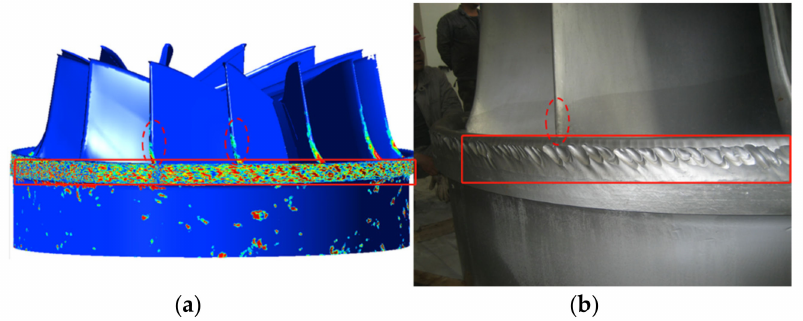
Figure 6. Sediment erosion at the clearance of the band. ( a ) CFD result; ( b ) physical wear